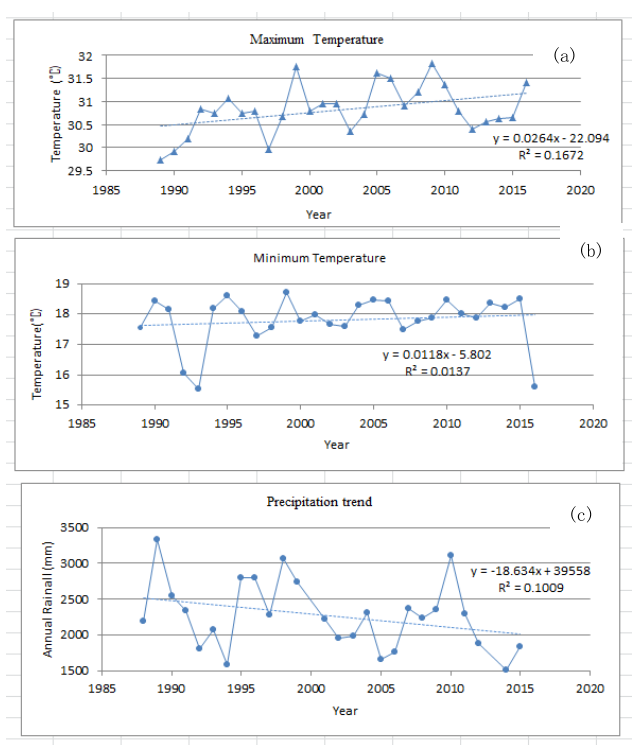
Figure A1. Maximum and minimum temperature ( a , b ) (Gaida-Kankai station) trend (1985–2020); Precipitation (Damak station) ( c ).